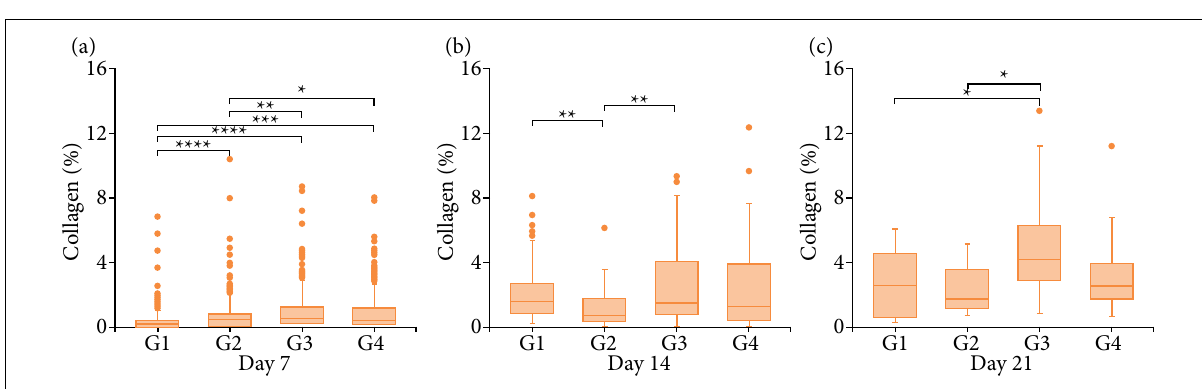
Figure 4 - Collagen rate evaluated in excisional wounds of rats treated with saline solution (G1), Hancornia speciosa latex-based cream-gel 5% (G2), 15% (G3) and 25% (G4)*. The statistical analysis considered a semi-quantitative analysis as follows: 0: absent; 1: discrete; 2: moderate; 3: accentuated. Statistical test used: Kruskal-Wallis’s